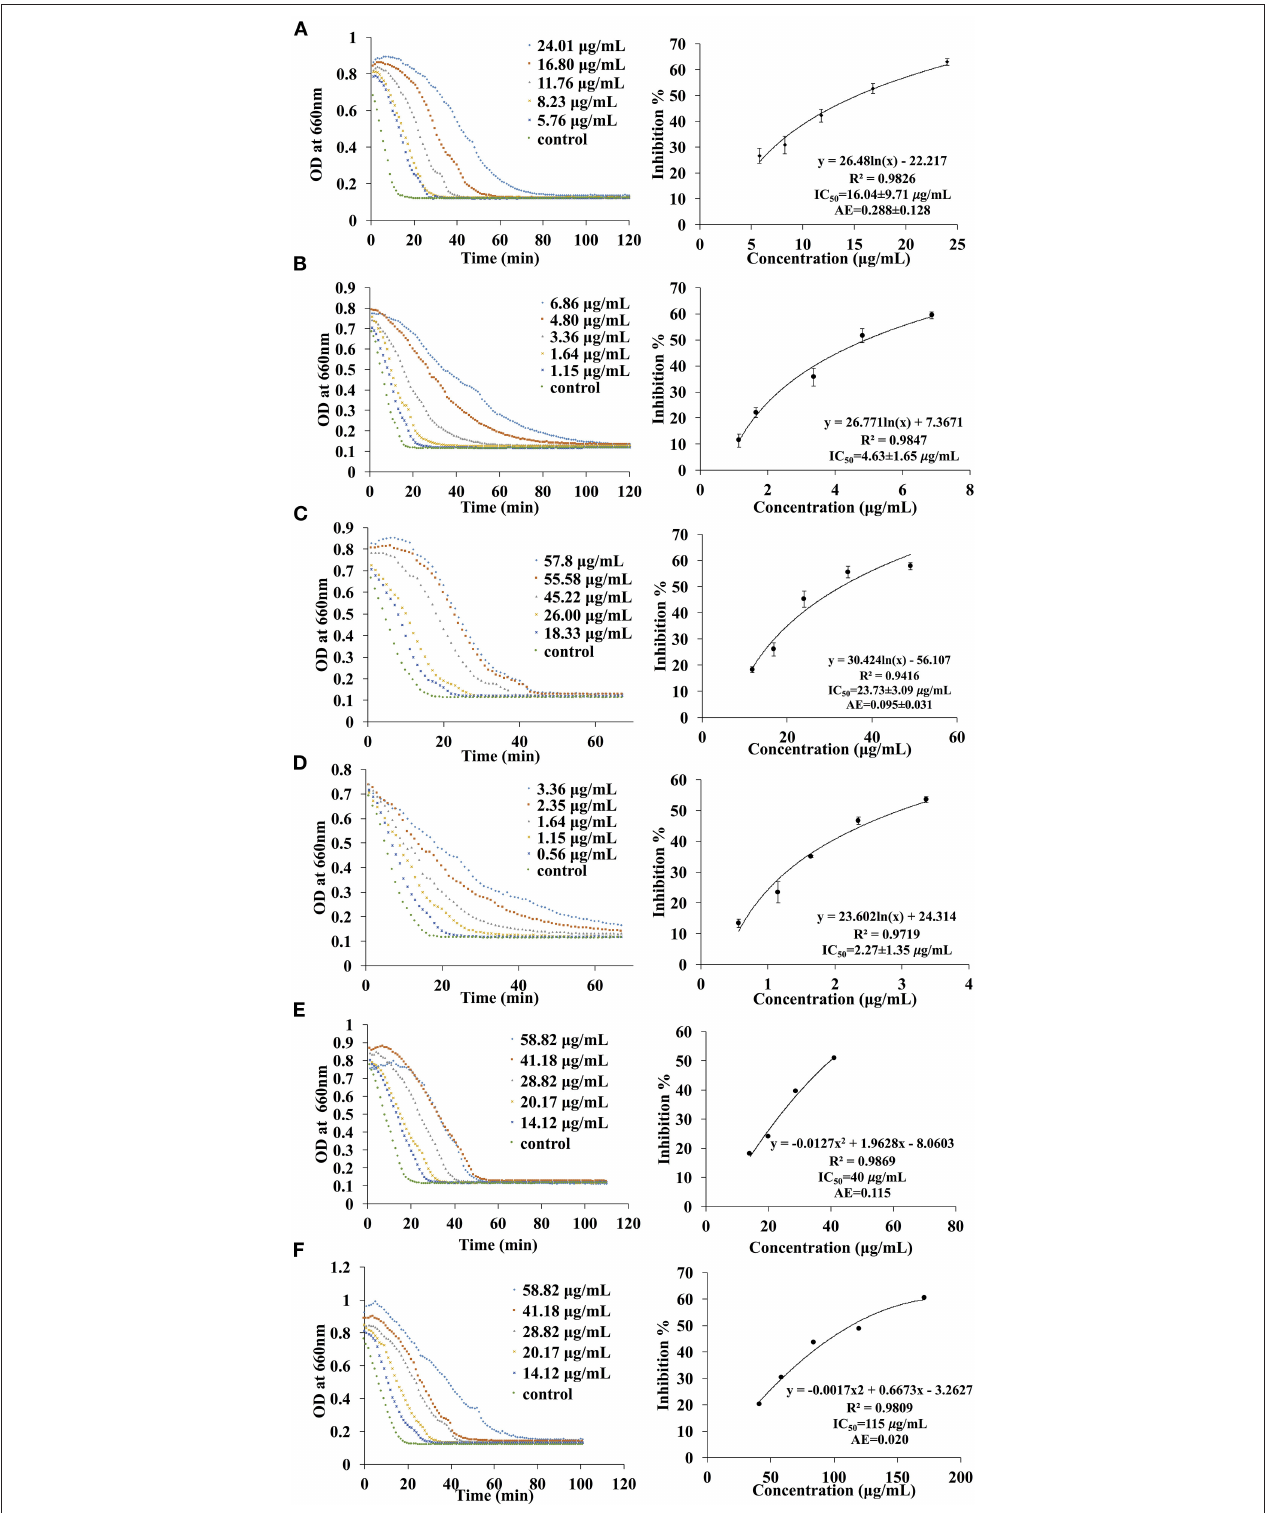
FIGURE 4 | The kinetic curve and dose responsive curve of starch hydrolase in the presence of different concentrations of (A) EA extract of P. viridiflora against pancreatic α -amylase, (B) acarbose against pancreatic α -amylase, (C) EA extract of P. viridiflora against α -glucosidase, (D) acarbose against α -glucosidase, (E) acetone extract of P. viridiflora against pancreatic α -amylase, (F) acetone extract of P. viridiflora against alpha-glucosidase.